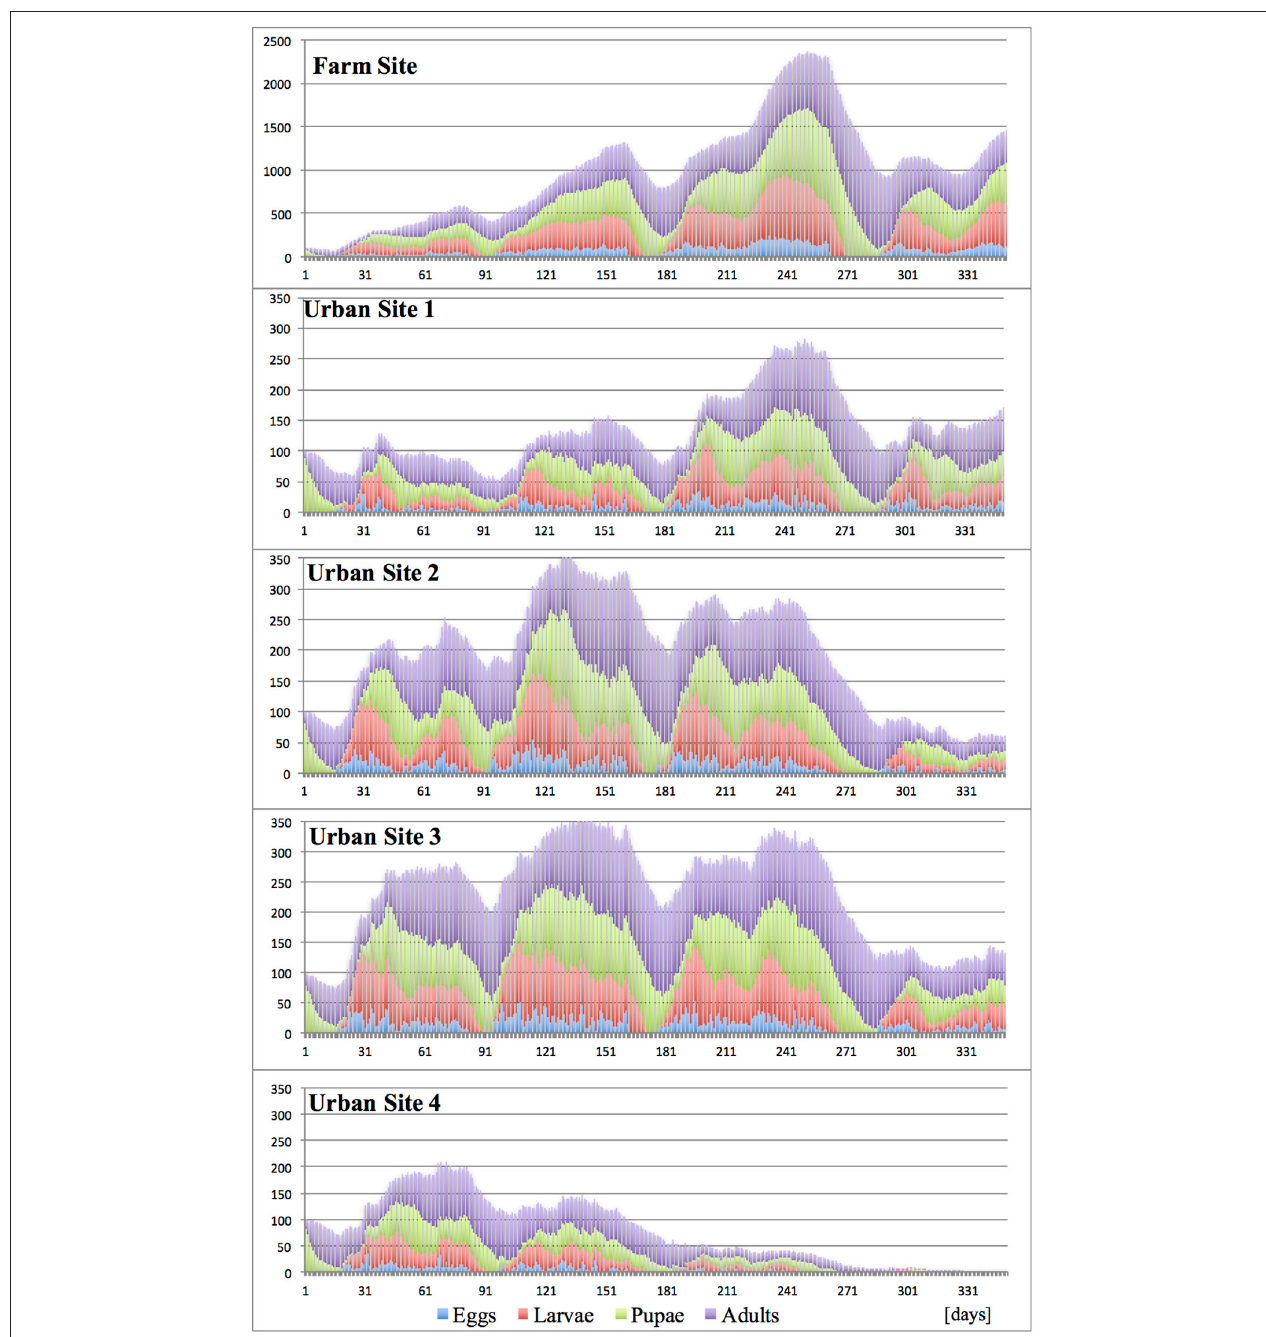
FIGURE 6 | Effects of site fragmentation on propagule development at constant temperature 25 ◦